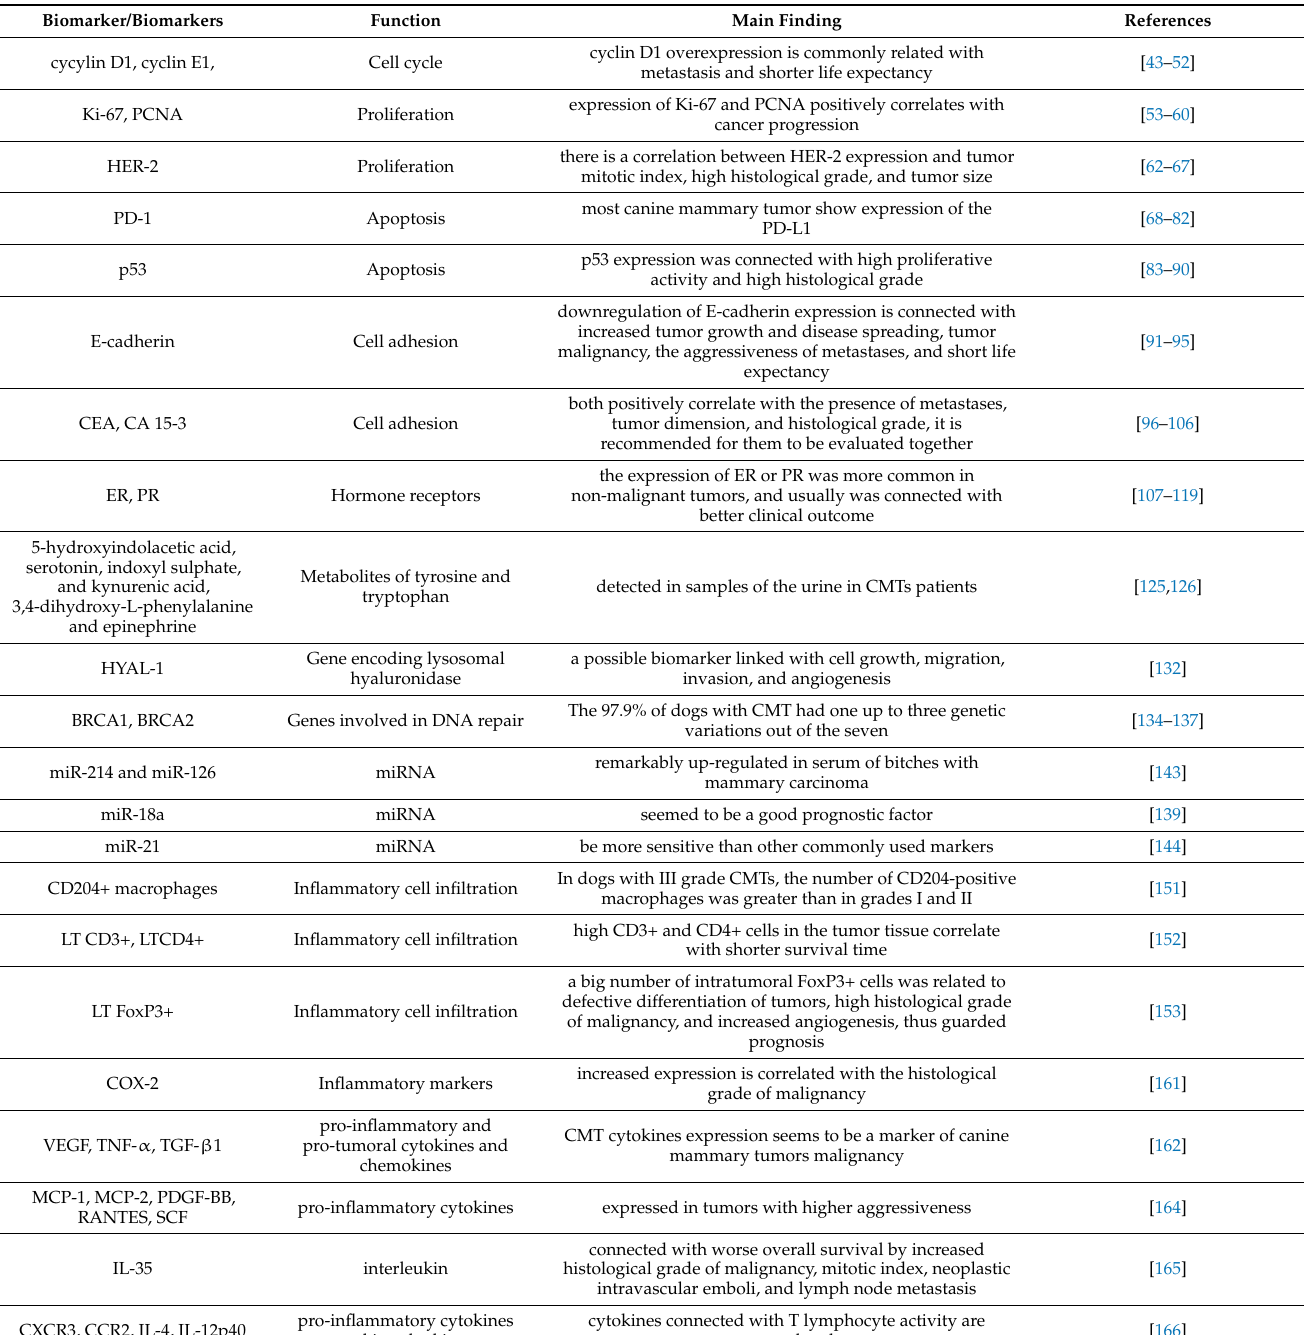
Table 1. Tissue and fluid biomarkers of mammary gland